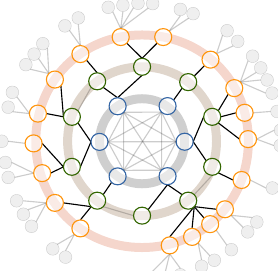
Figure 3: Hierarchy used for setting the subnetwork man- aged by each router (represented as empty